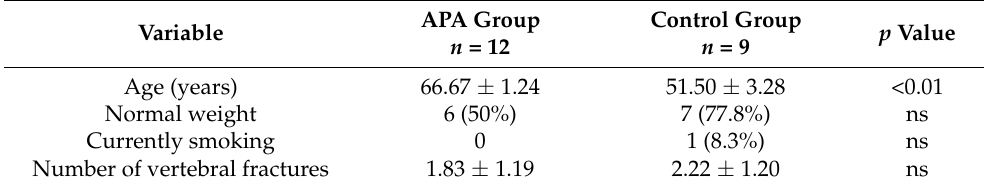
Table 1. Baseline characteristics of the